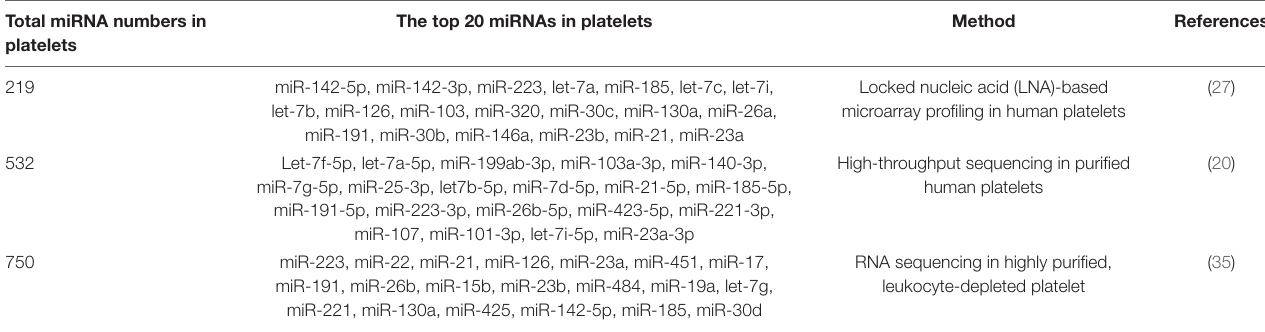
TABLE 1 | A summary of the top 20 expressed miRNAs in